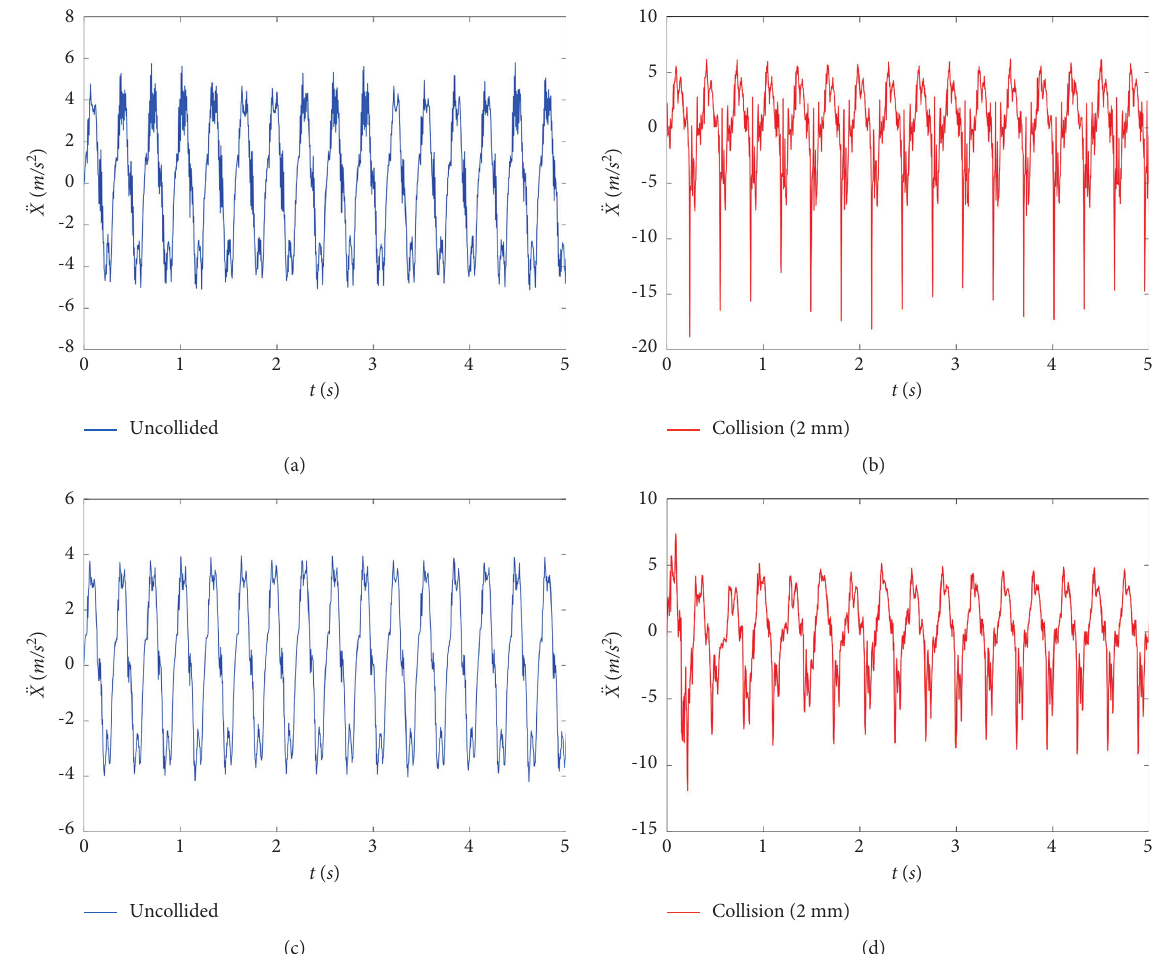
Figure 12: Acceleration histories of the top and third story of structure A under pounding and nonpounding loading. (a, b) Acceleration response histories of the top structure. (c, d) Acceleration response histories of the third story